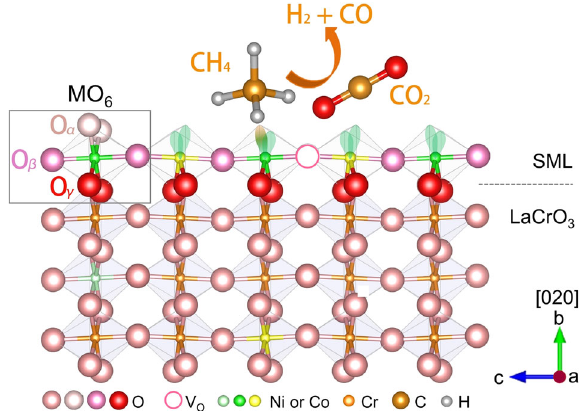
Fig. 7 Schematic diagram of LNCO-SML stabilized by perovskite LaCrO 3 surface lattice (space group Pbnm, La not shown). LNCO-SML represents La(NiCo)O Δ submonolayer. M represents Ni or Co. TheMO 6 octahedron in the gray rectangle represents a Ni 3 + or Co 3 + cation coordinated to six O 2- anions. O α , O β , and O γ have different bonding con fi gurations with M and Cr. CH 4 and CO 2 are the reactants, and H 2 and CO are the products of DRM. Losses of O α andO β willreduceNi 3 + orCo 3 + cationstothelow-valentstates(Ni δ + orCo δ + ) and expose the Ni or Co 3d orbitals to thereactants (or